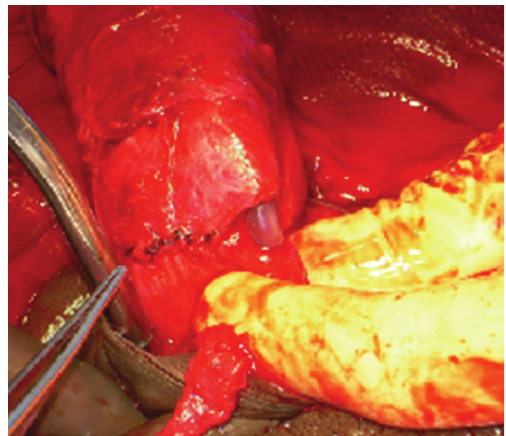
Figure 1: Preoperative examination.